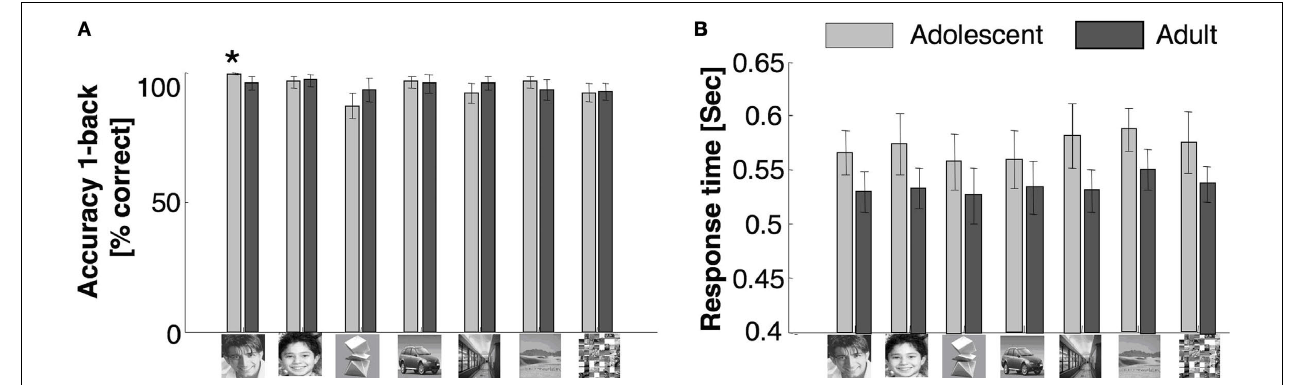
FIGURE 1 | Behavioral data during scan. (A) Accuracy and (B) response times in a 1-back task during the scan. Light gray: adolescents ages 12–16 years; Black: adults ages 18–40 years. Error bars show standard error of mean (SEM) for each age group. Asterisk indicates signifi cantly higher accuracy in adolescents than adults ( P < 0.05, t -test).